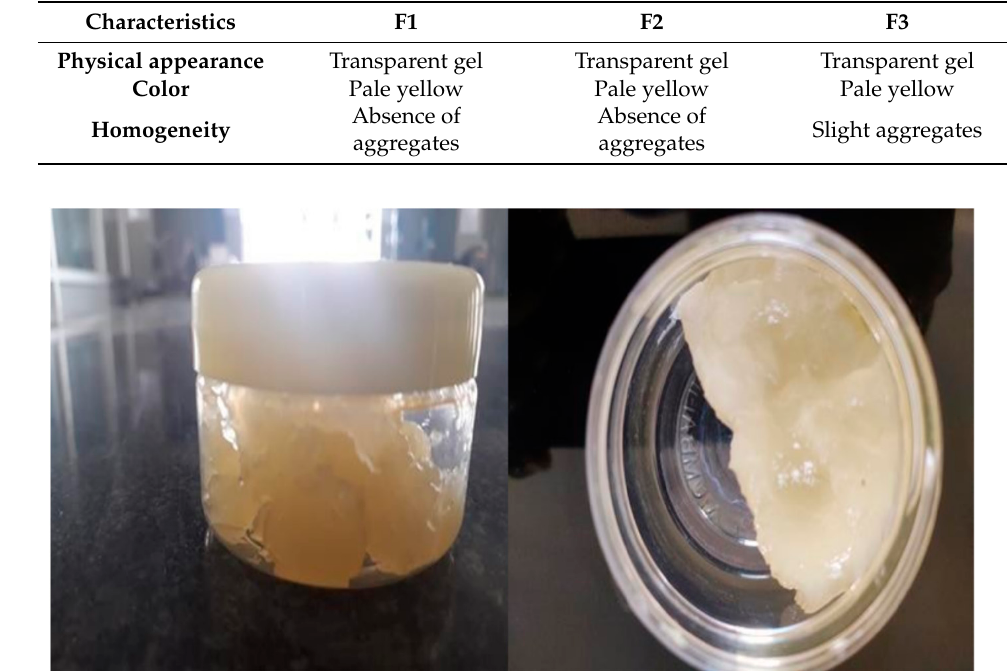
Figure 7. Image of formulated polyherbal gel containing Vigna radiata and Aloe barbadensis